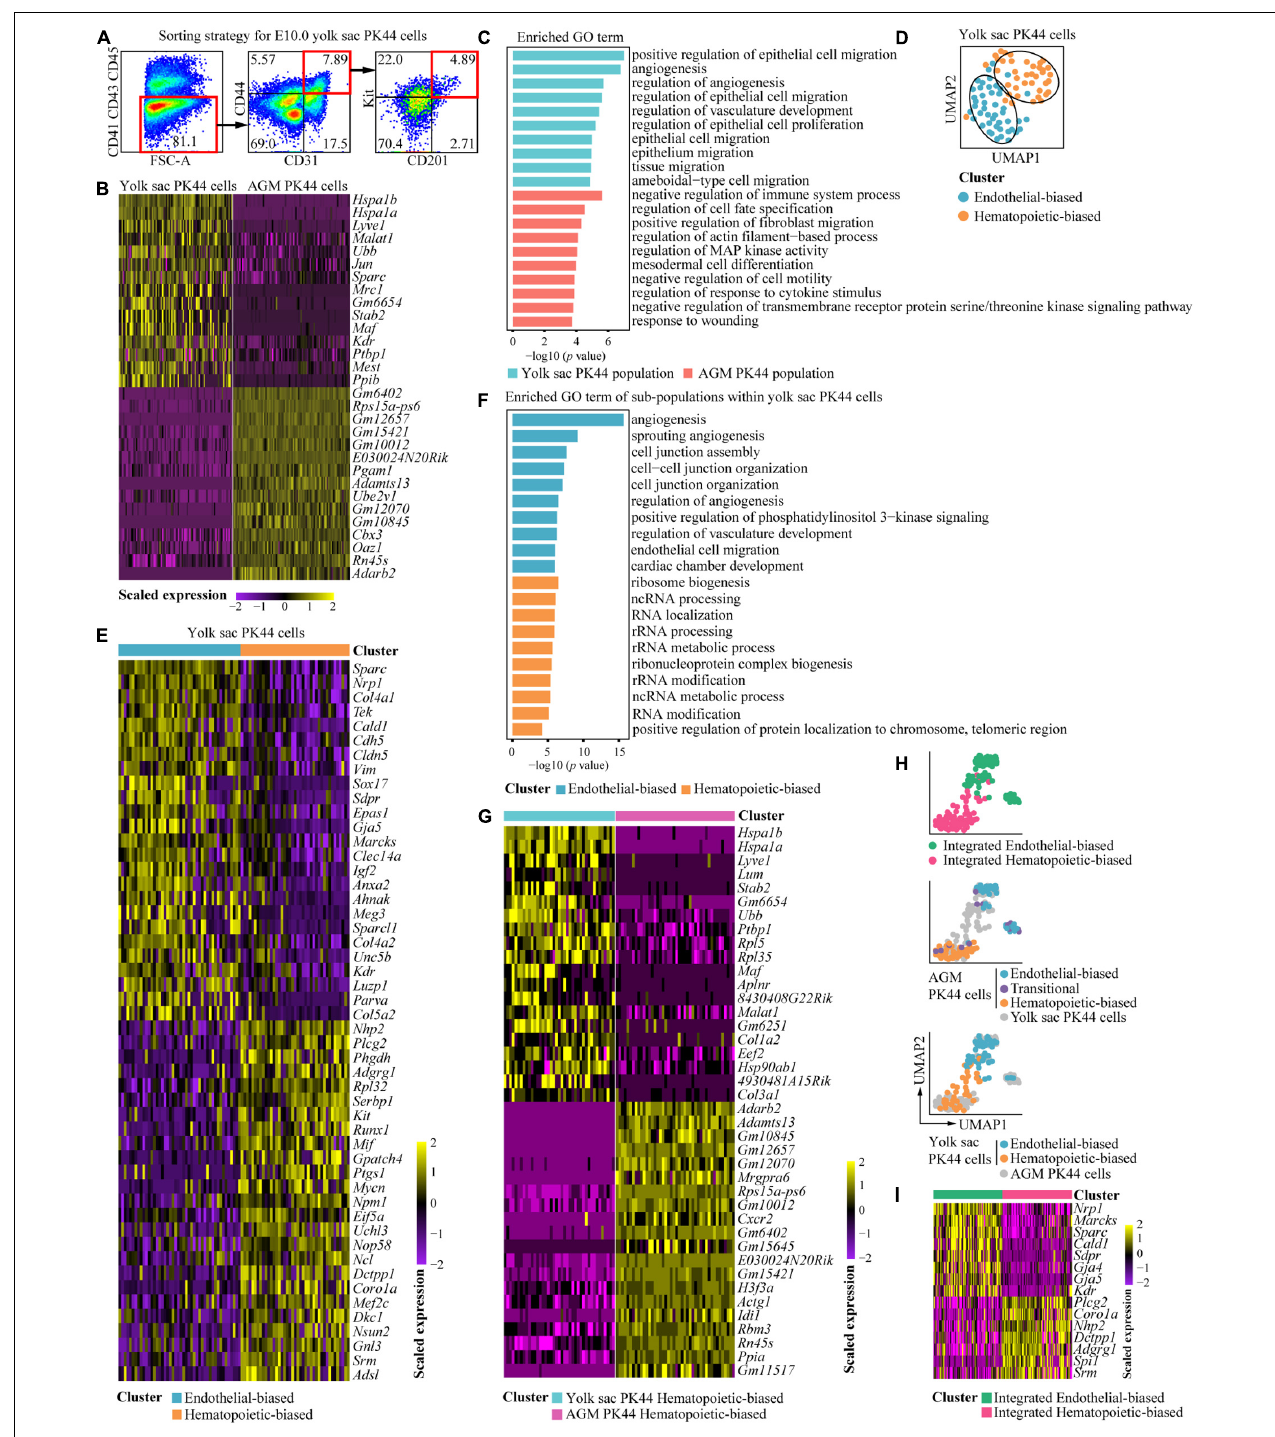
FIGURE 5 | Transcriptomic characteristics of E10.0 yolk sac PK44 cells. (A) Flow cytometry gating strategy for isolating PK44 cells in E10.0 yolk sac. (B) Heatmap showing the top 15 DEGs between E10.0 yolk sac and AGM PK44 cells. (C) Enriched GO terms of E10.0 yolk sac and AGM PK44 populations. (D) UMAP plots of the E10.0 yolk sac PK44 cells with clusters mapped on. (E) Heatmap showing top 25 DEGs between two subpopulations (endothelial- and hematopoietic-biased) in E10.0 yolk sac PK44 cells. (F) Enriched GO terms of two subpopulations (endothelial- and hematopoietic-biased) in E10.0 yolk sac PK44 cells. (G) Heatmap showing top 20 DEGs between hematopoietic-biased subpopulation in E10.0 yolk sac PK44 cells and that in E10.0 AGM PK44 cells. (H) UMAP of integrated data of E10.0 AGM and yolk sac PK44 cells with subpopulations (endothelial-biased, transitional, and hematopoietic-biased population) mapped on. (I) Heatmap showing DEGs between the integrated endothelial- and hematopoietic-biased populations.